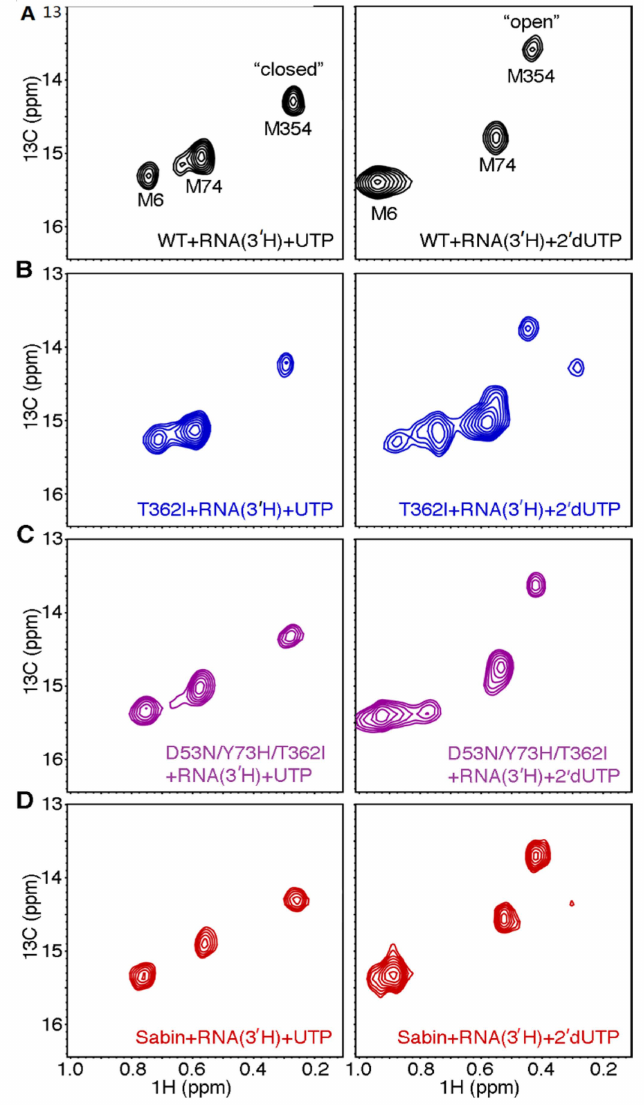
Figure 5. The Sabin I RdRp does not readily populate the closed conformation when incorrect nucleotide